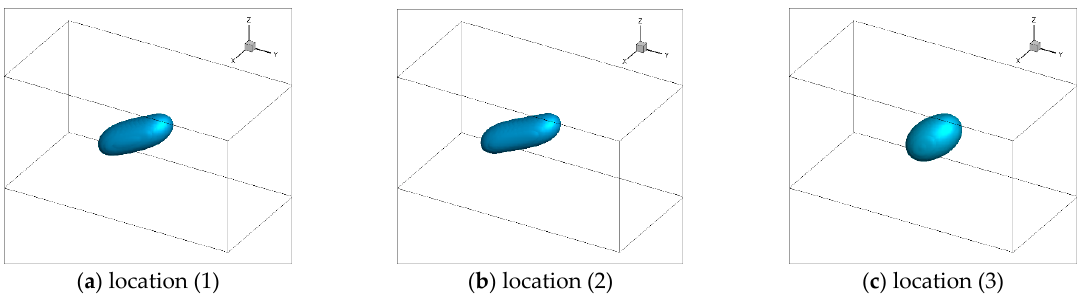
Figure 15. Simulated morphology of droplet A under low injection rate. Figures 16 and 17 demonstrated the SEM images taken from the part of case I and III.